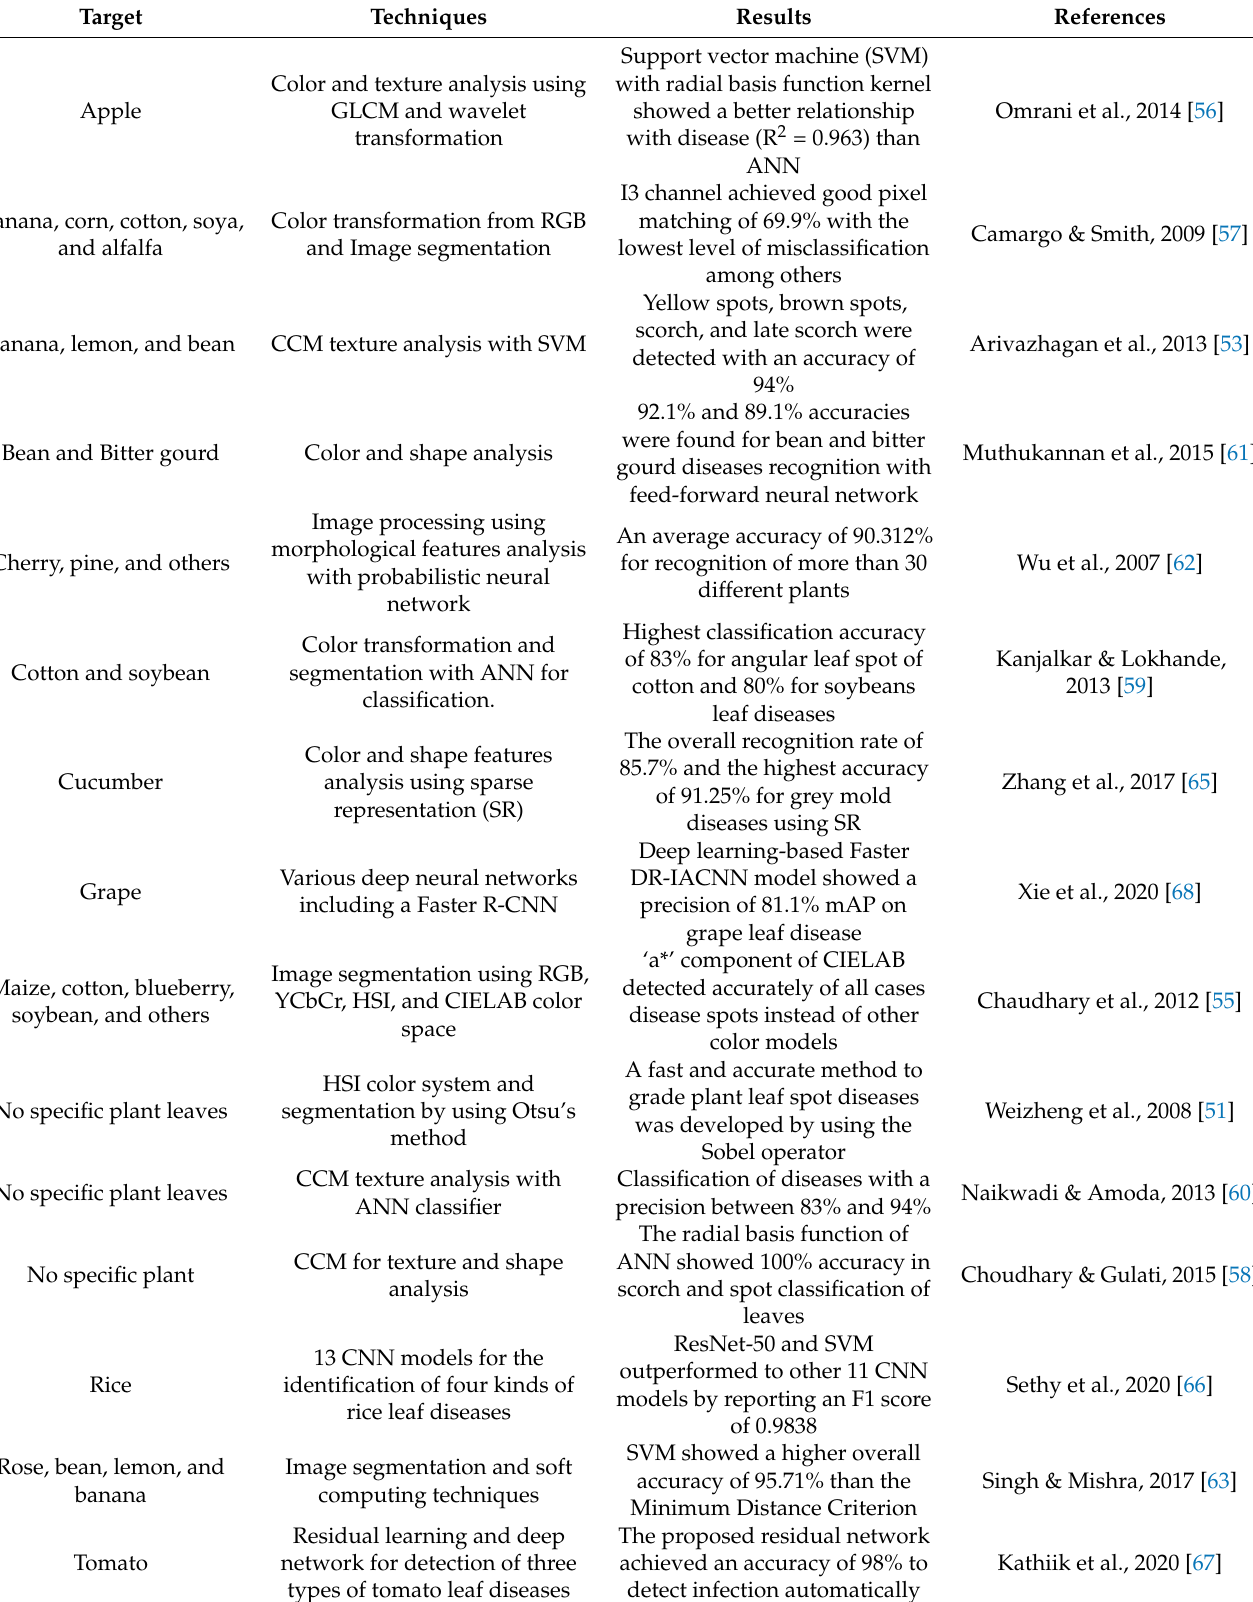
Table 2. Application of machine vision for disease detection on